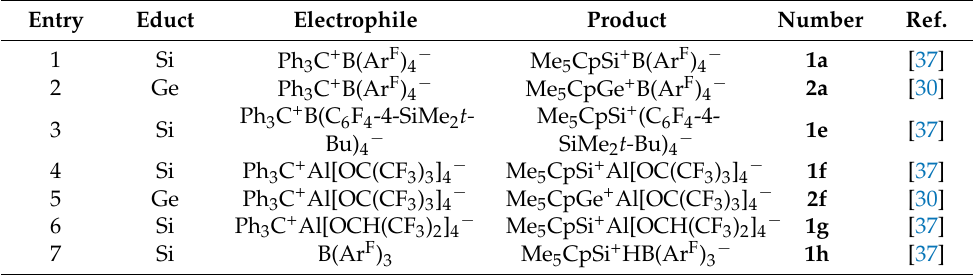
Table 2. Synthesis of catalysts 1 and 2 , by hydride transfer reaction from the corresponding tetrelocenes 3 and 4 to electrophiles [30,37].